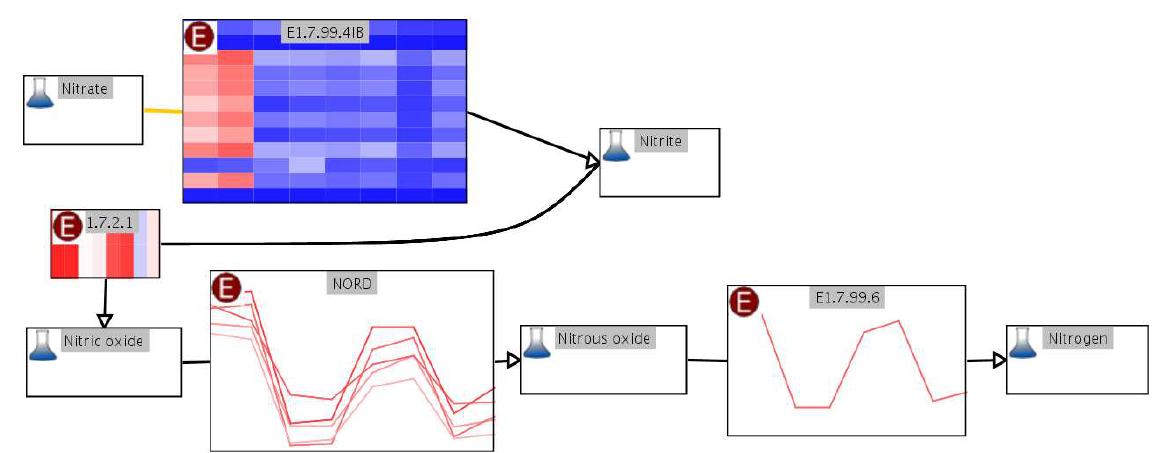
Figure 3: Part of the nitrogen metabolism (KEGG id pae00910) visualized with overlaid enzyme expression values. All probes associated with the relevant enzymes are shown, either as profiles or as heatmap rows. Expression values are encoded as colors (low=blue, high=red) and as profiles. Conditions are sorted in ascending order by oxygen concentration (anaerobic, 0.4%, 2%, 20%), with both replicates per condition shown as separate adjacent experiments. Enzymes are marked with the letter “E”, metabolites are marked with the image of an Erlenmeyer flask. Components are labelled with names assigned by